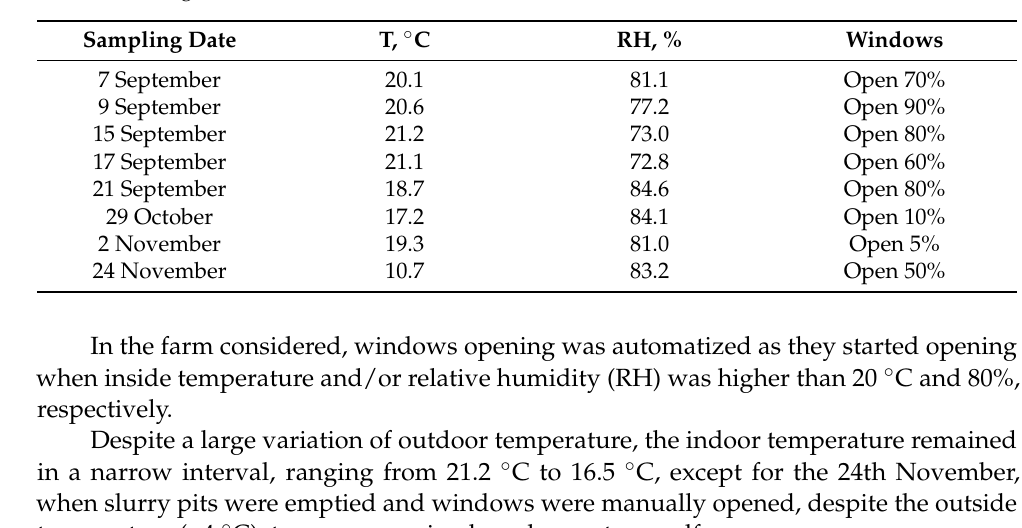
Table 3. Average environmental conditions inside the barns.